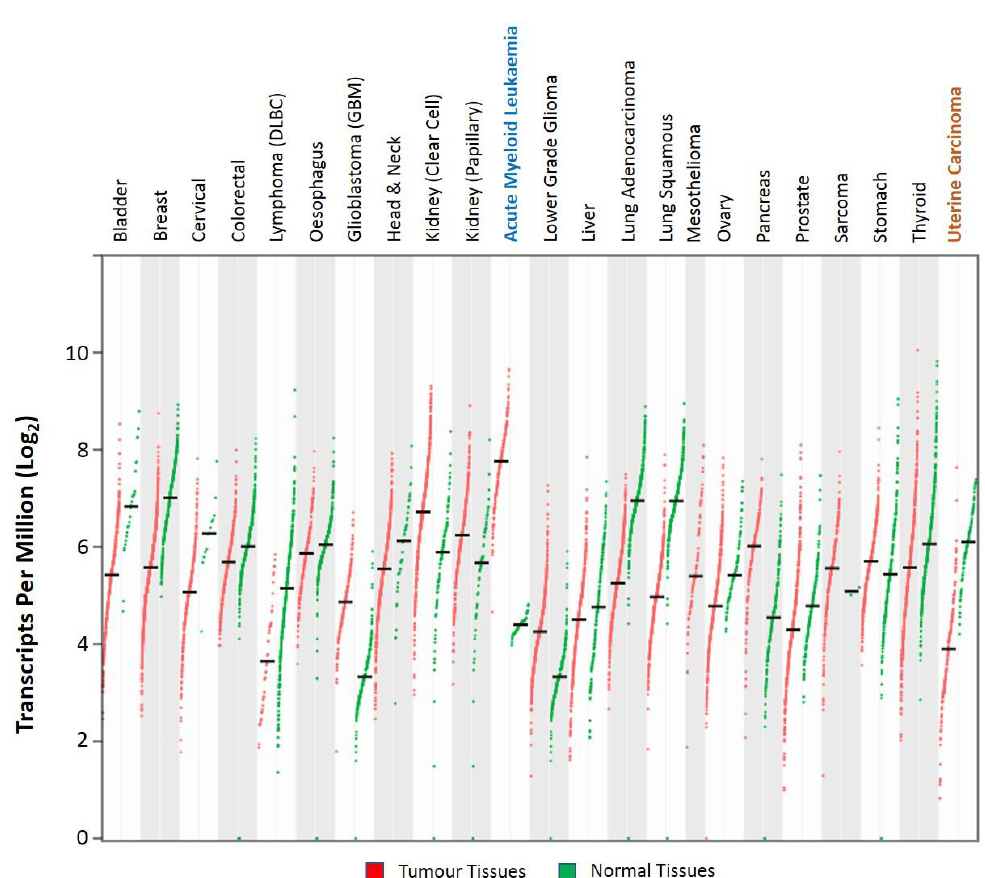
Figure 6. Dot plots representing the KLF6 expression RNA-Seq data in tumour and normal tissue samples from The Cancer Genome Atlas (TCGA) and The Genotype-Tissue Expression (GTEx) databases, respectively. KLF6 was found to be significantly upregulated and downregulated in acute myeloid leukaemia and uterine carcinoma, respectively (Log 2 FC | 2 | ; p -value < 0.05). The data were analysed and visualised using the GEPIA2 web application [80].